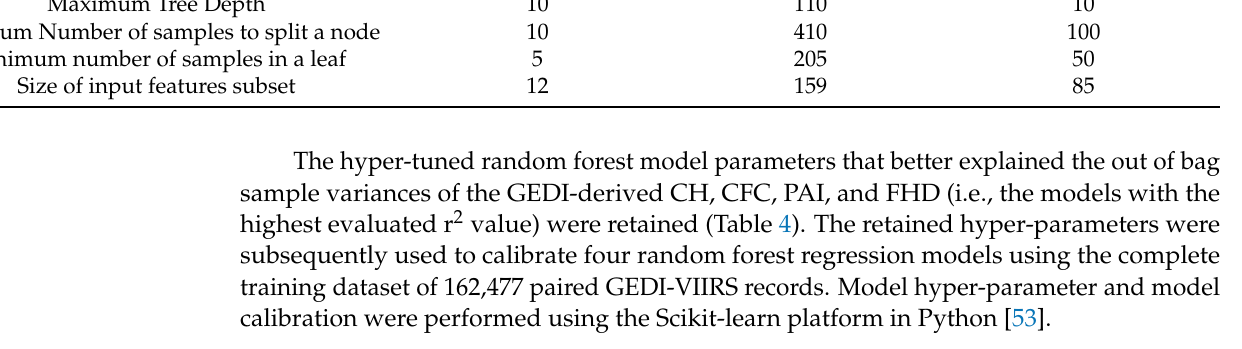
Table 4. Optimal hyper-parameter values for the four Random Forest Regression